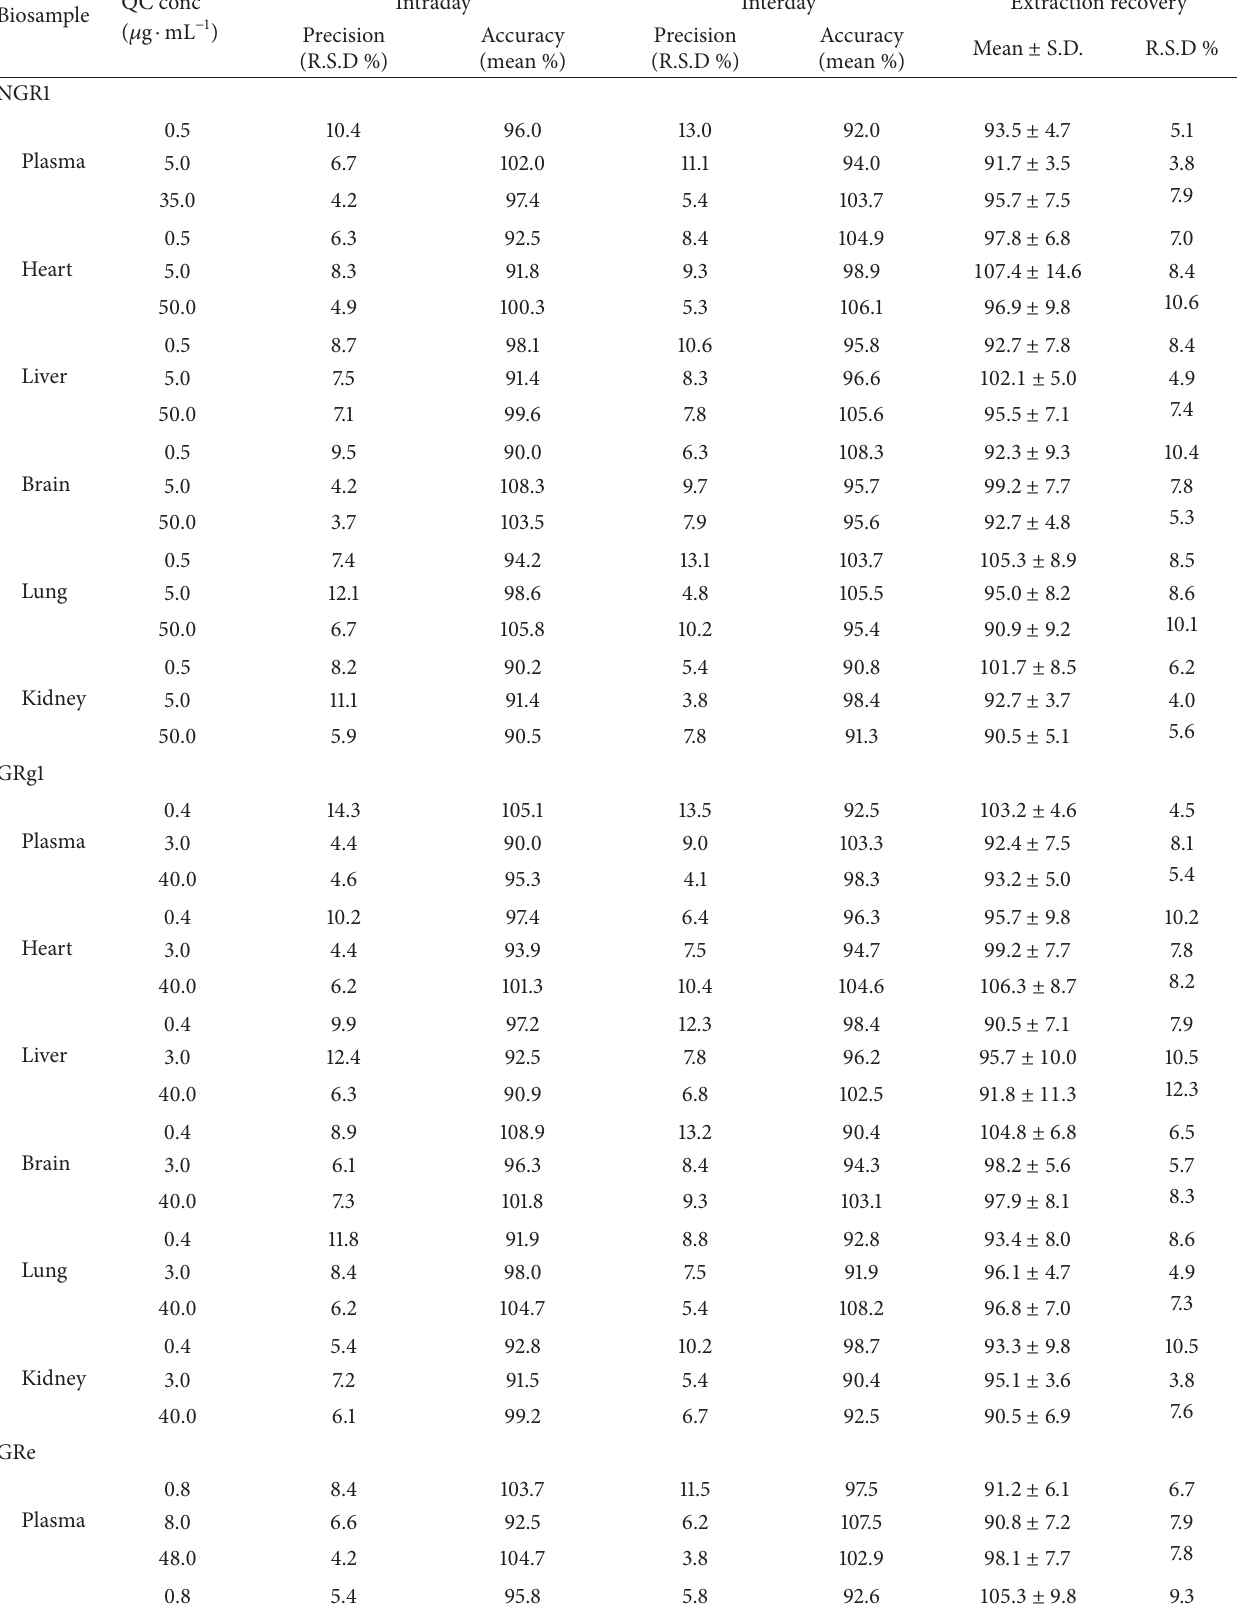
Table 2: The interday and intraday precision and accuracy of the method for the determination of NGR1, GRg1, and GRe ( 𝑛 = 5 ).